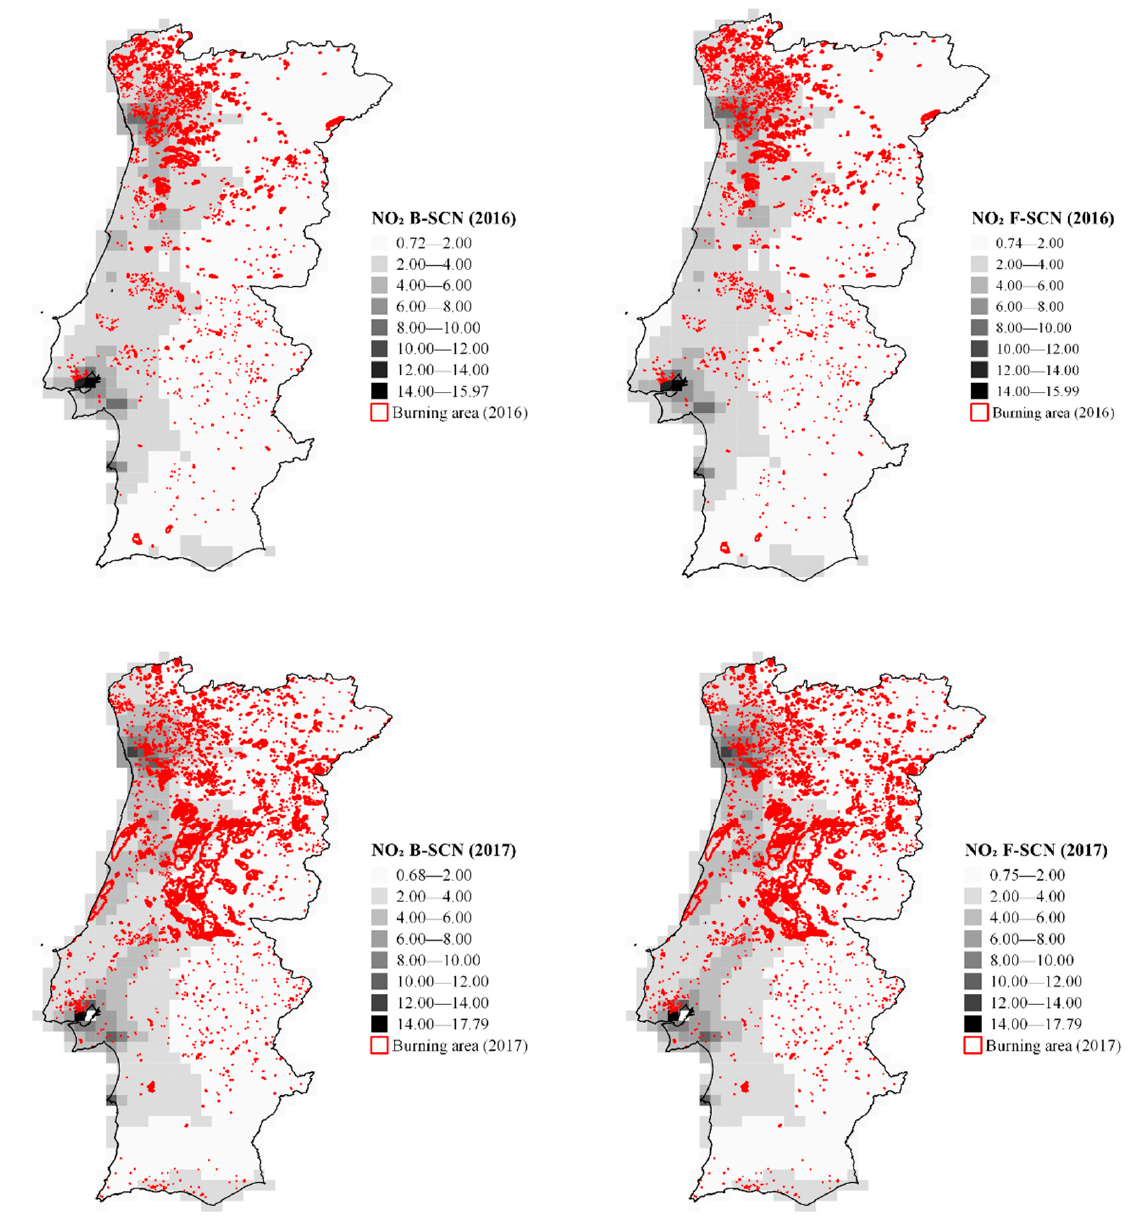
Figure 1. Spatial distribution of annual mean concentrations of NO 2 in the study domain for 2016 and 2017, considering (F-SCN) and not considering (B-SCN) wildland fire emissions. Concentrations are in µ g m − 3 . The burnt area is represented in red.